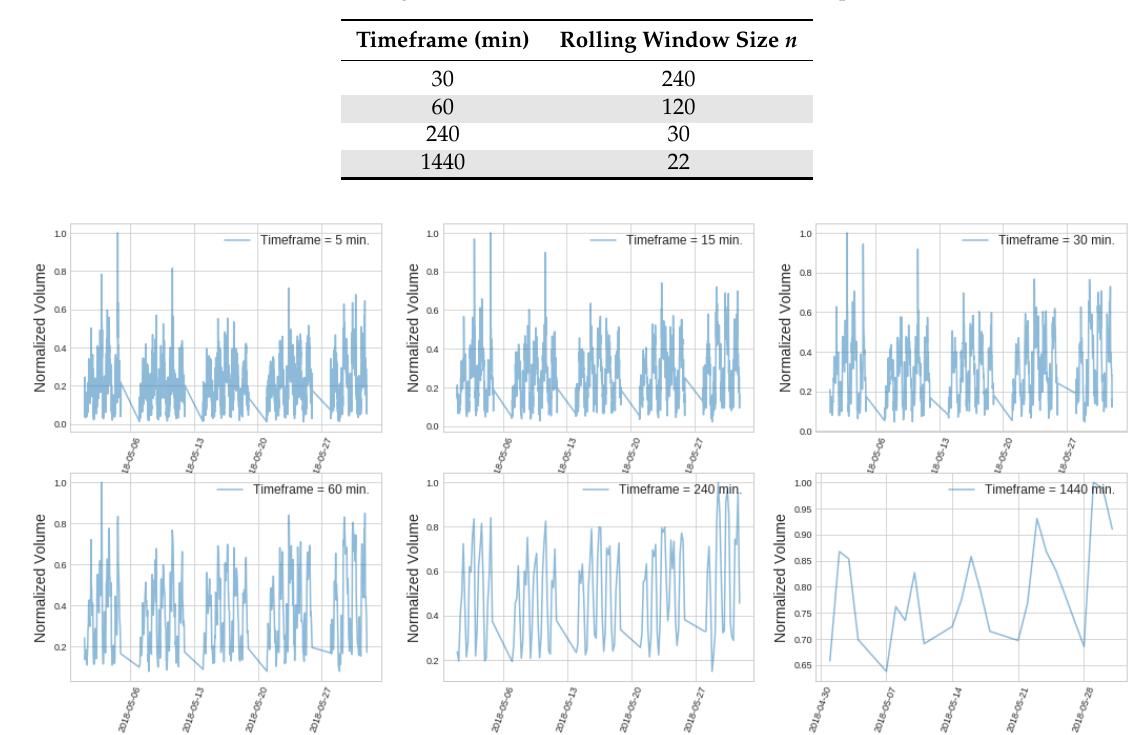
Table 1. Rolling window size n shrinks as the timeframe expands.